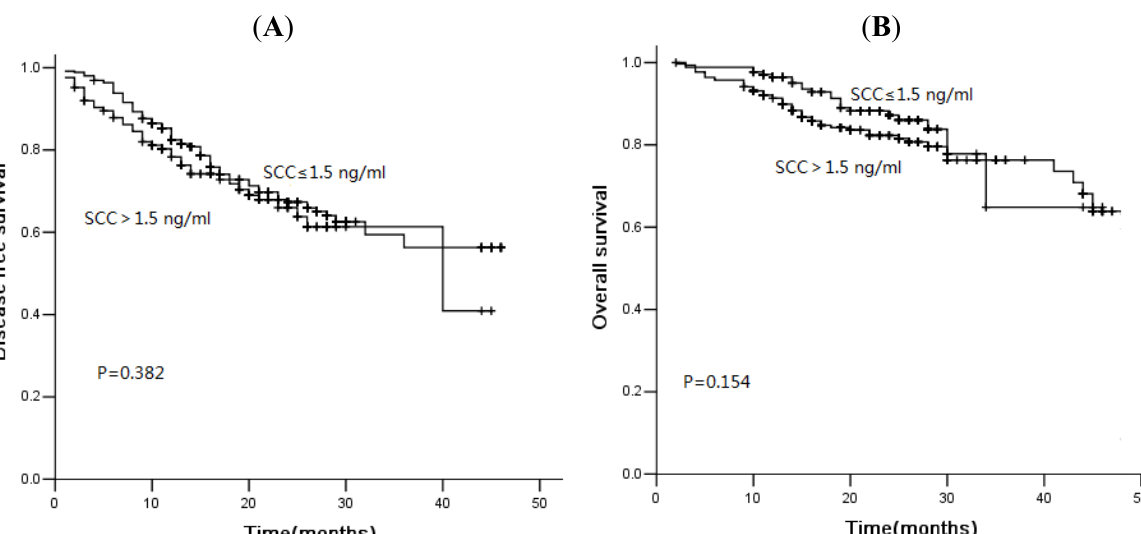
Figure 3. Kaplan-Meier disease-free survival curves ( A ) and overall survival curves ( B ) according to SCC: The serum level of SCC was not associated with disease-free survival (DFS) or overall survival